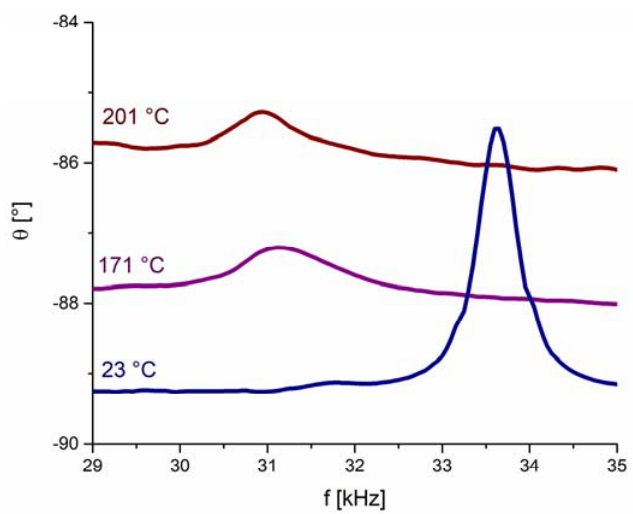
Figure 3. Phase angle θ as a function of frequency f for the resonant sensor measured at three different temperatures. The density of measured points is 20 kHz − 1 .